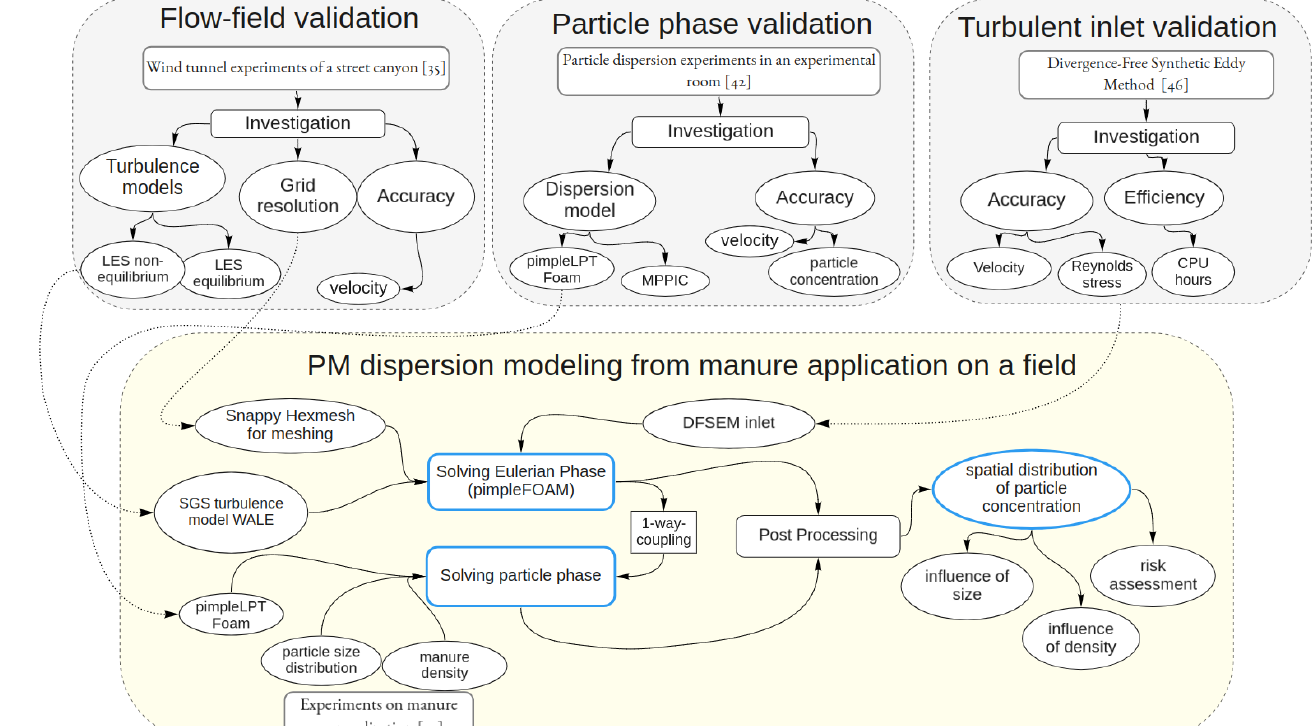
Figure 1. Structure of the study and illustration of the work- and information